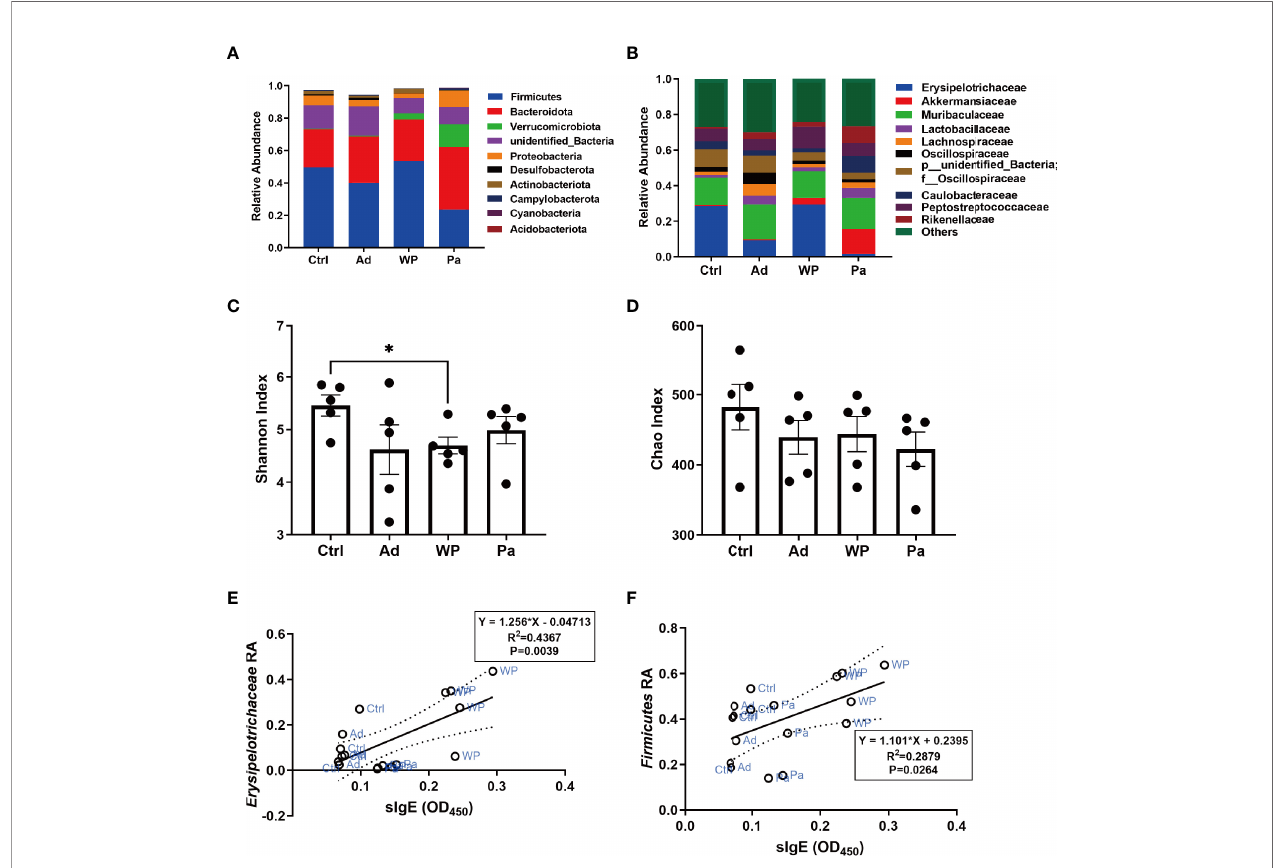
FIGURE 6 | Bacterial composition of mouse gut at the phylum (A) and genus (B) levels. Signi fi cance test of Shannon index (C) and Chao index (D) . Correlation analysis of gluten-speci fi c IgE concentration and abundance of two representative bacteria (E , F) . The dashed lines in (E, F) are the 95% con fi dence intervals of linear models (solid lines). RA, relative abundance. Data are shown as the mean value ± standard error of the mean of fi ve independent experiments. The asterisk indicates a statistically signi fi cant difference ( P